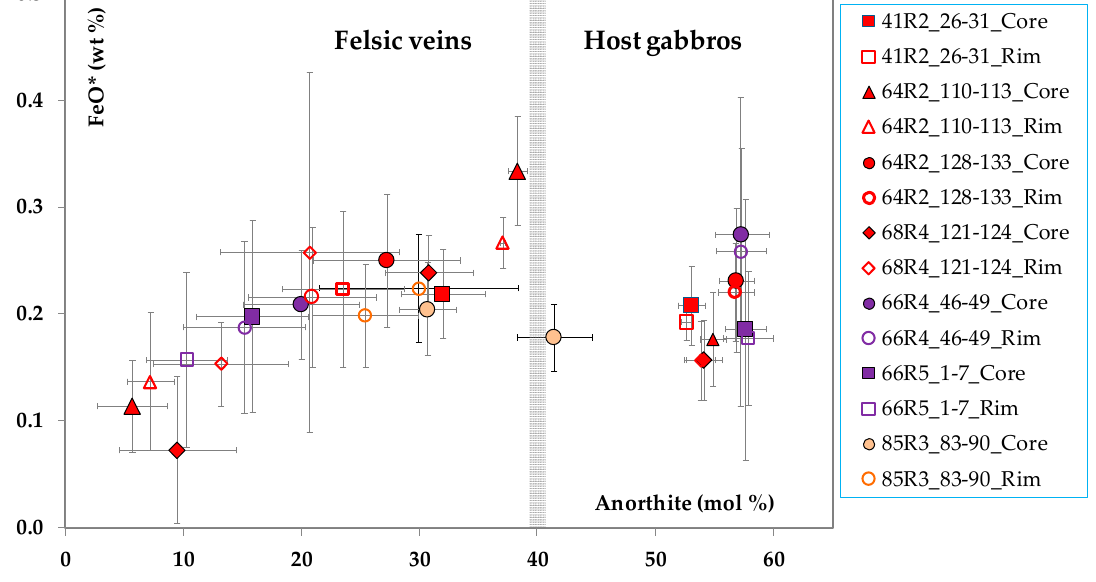
Figure 12. Average plagioclase anorthite content plotted versus FeO* (total iron oxides, wt.%); each point is the average of 1 domain in 1 sample and bars are 1 σ standard deviations. Same symbols and colors indicate pairs of host—felsic rocks in 1 thin section; solid and open symbols are the average composition of the cores and rims, respectively. Grey band roughly shows the geochemical boundary of host gabbros–felsic rocks.